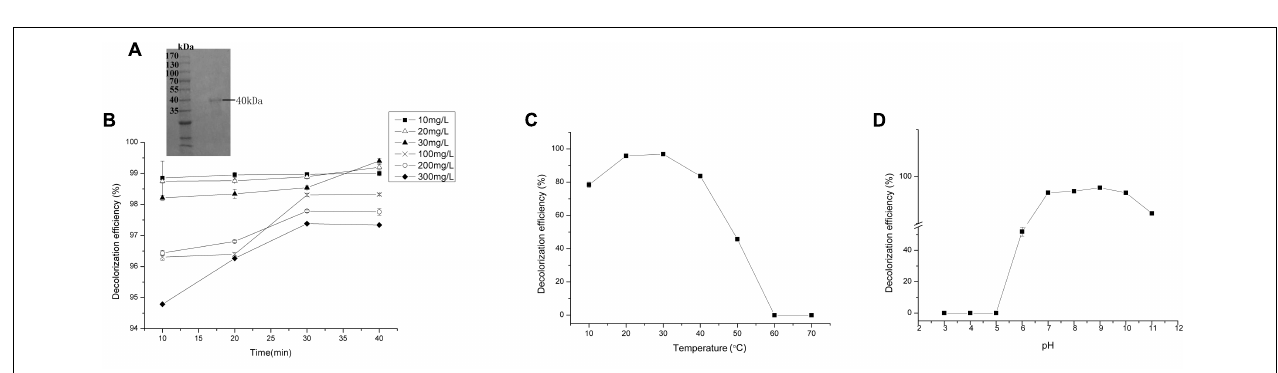
FIGURE 2 | Bioinformatics analysis of putative malachite green-degrading genes (MDGs). (A) Distribution of best identity in Nr database of all open reading frames (ORFs) and putative MDGs. (B) The number of 44 putative MDGs in the dataset of mangrove sediment microbiome. (C) The bacteria origin of putative MDGs. The numbers on the X -axis indicated the genera of Nitrososphaera, Acidovorax, Desulfuromonas, Chromobacterium, Geopsychrobacter, Cellvibrio, Shewanella, Simiduia, Oscillatoria, Thiothrix, Thiocapsa, Draconibacterium, Frankia, Nitrosomonas, Sedimenticola, Bizionia, NO-TaxID , Formosa, norank, Leucothrix, Magnetococcus, Spirochaeta, Rhodanobacter, Gemmobacter, Kangiella, Gaetbulibacter, Mariniradius, Zooshikilla, Imtechella, Salinibacter, Gelidibacter, and Marinobacter , respectively.